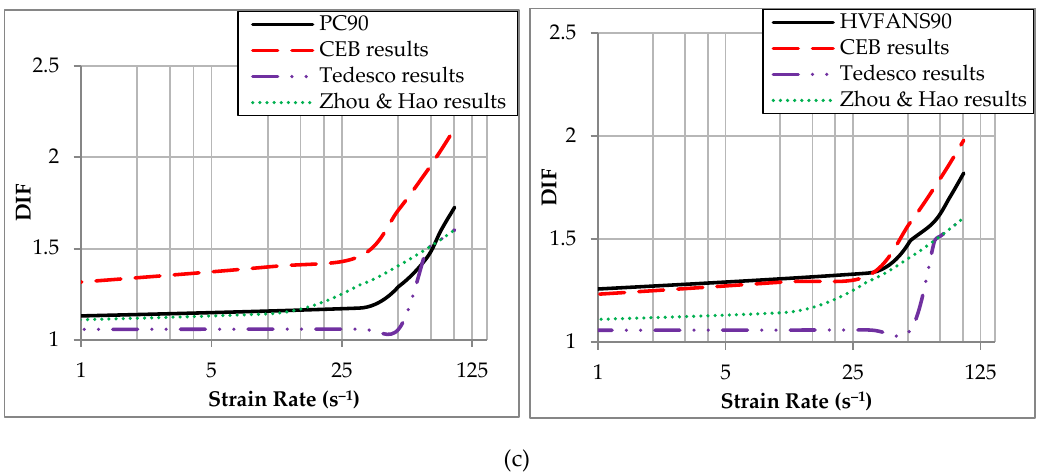
Figure 13. Comparison of DIF with the previously recommended expressions at different curing ages and temperatures of ( a ) 25°C, ( b ) 400 °C and ( c ) 700 °C.